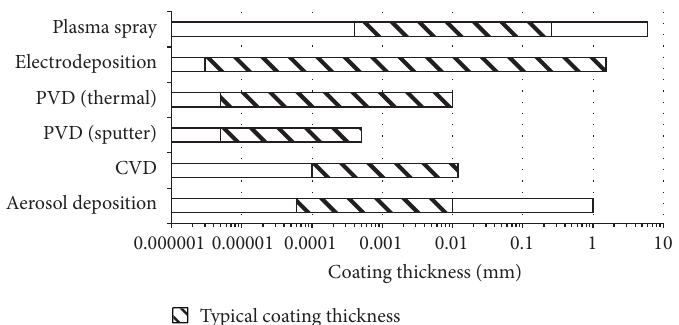
Figure 1: Graphical summary of coating thickness of presented processes.